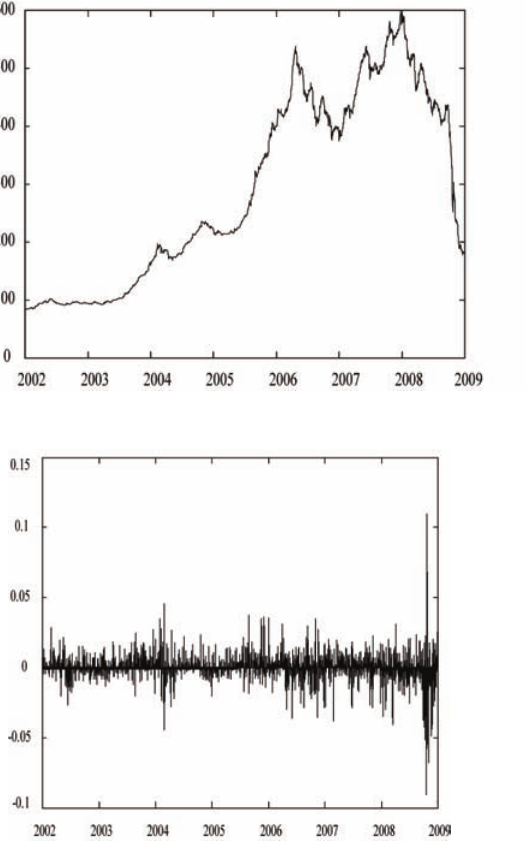
Fig. 1. VILSE Index Values and Return, Period